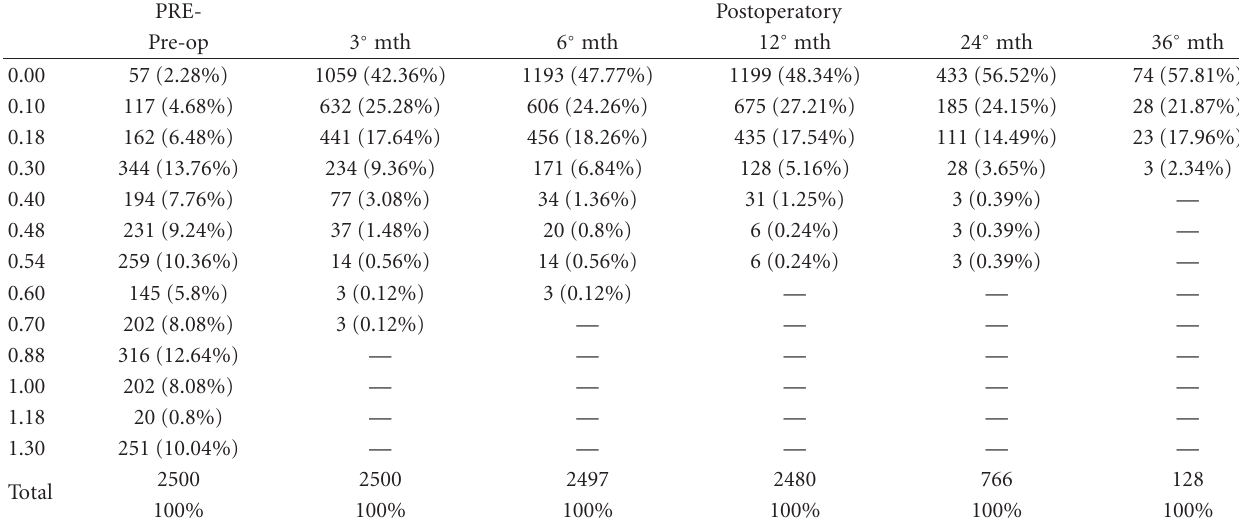
Table 2: UDVA in di ff erent periods during the followup.